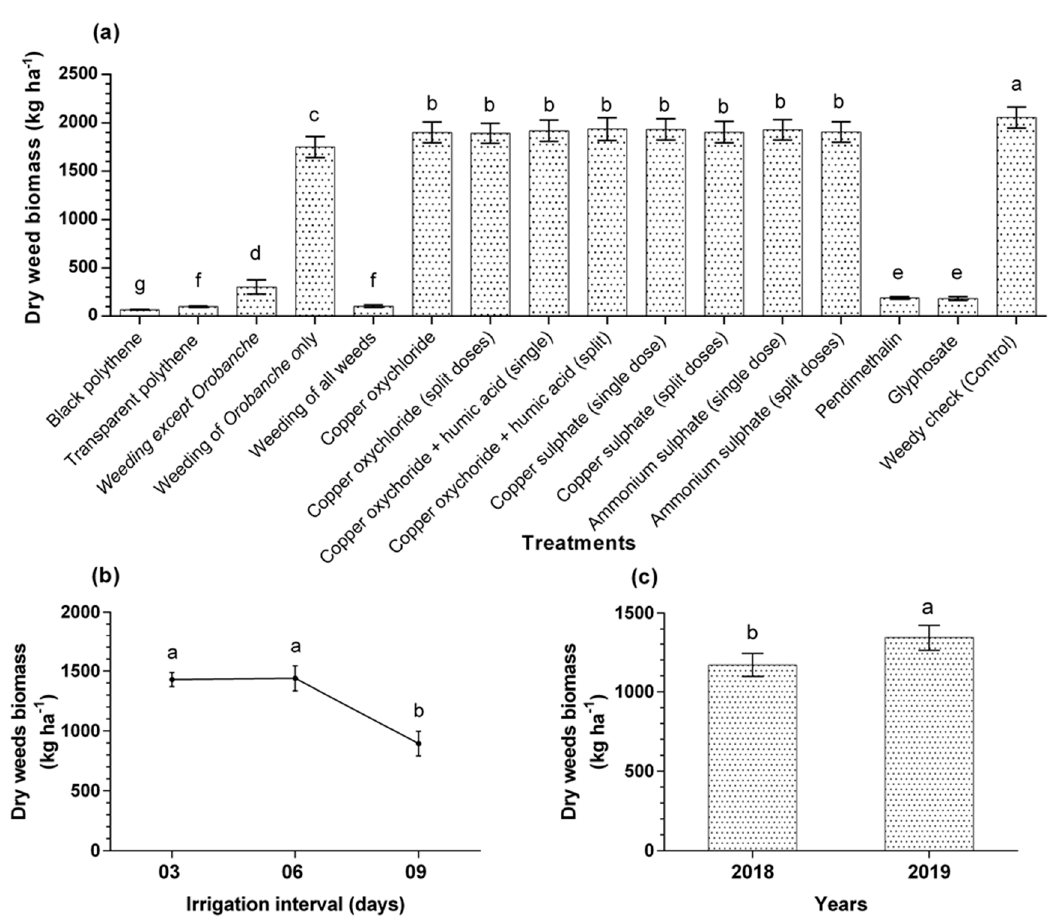
Figure 7. Influence of various irrigation intervals, weed management treatments, and years on dry weeds biomass (kg ha − 1 ). ( a ) Effect of treatments on dry weed biomass. ( b ) Effect of irrigation intervals on dry weed biomass. ( c ) Effect of different years on dry weed biomass. Based on the Least significant difference test, line and column ± standard error followed by different alphabetical letters are significantly different from each other at a 5% level of probability .